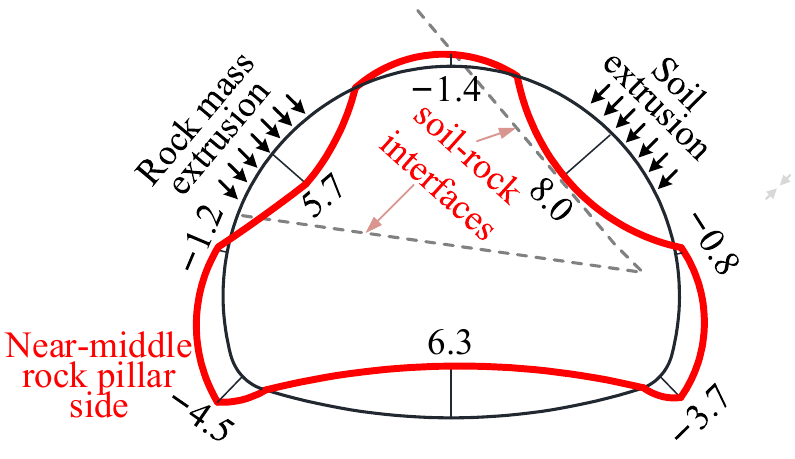
Figure 8. ZK0+730 measured bending moment (unit: kN · m).